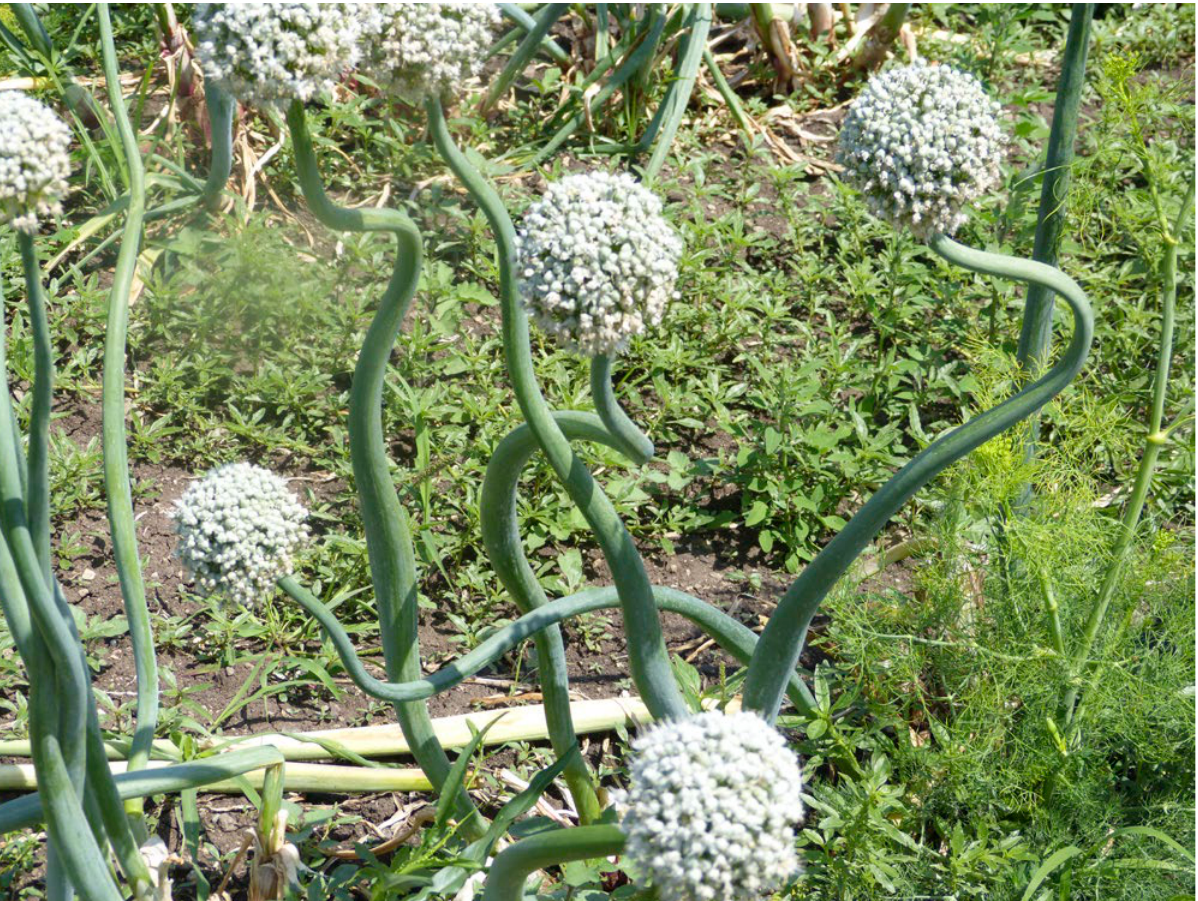
Figure 1. Flower stems from an onion seed crop showing distortion and curling caused by